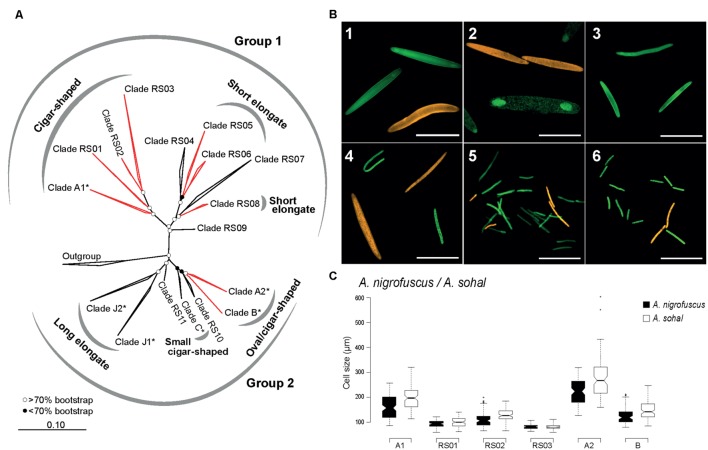
Phylogenetic and morphological diversity of Epulopiscium-like 16S rRNA gene sequences from the central Red Sea. (A) ML 16S rRNA phylogeny. Open and filled circles denote branches with bootstrap support values of >70 or <70%, respectively, based on maximum-likelihood and Bayesian trees. Epulopiscium clades that have previously been morphologically characterized elsewhere (in Hawaii or the Great Barrier Reef) are starred (∗), and clades investigated by FISH are labeled in red. (B) FISH of several clades in A. sohal and Z. desjardinii: 1) A1 (Cy3-labeled, orange) and A2 (fluorescein-labeled, green) in A. sohal, 2) A2 (orange) and B (green) in A. sohal – note that A2 cells are internal offspring that still resides within a mother cell, 3) RS01 in A. sohal (green), 4) RS02 (orange) and RS03 (green) in A. sohal – RS03 cell on the top left corner seems to be undergoing binary fission, 5) RS05 (green) and RS06 (orange) in Z. desjardinii, 6) RS06 (orange) and RS08 (green) in Z. desjardinii. The scale bars represent 100 μm in images 1–4 and 50 μm in images 5 and 6. (C) Cell size distribution of different cigar-shaped clades found in A. sohal and A. nigrofuscus.